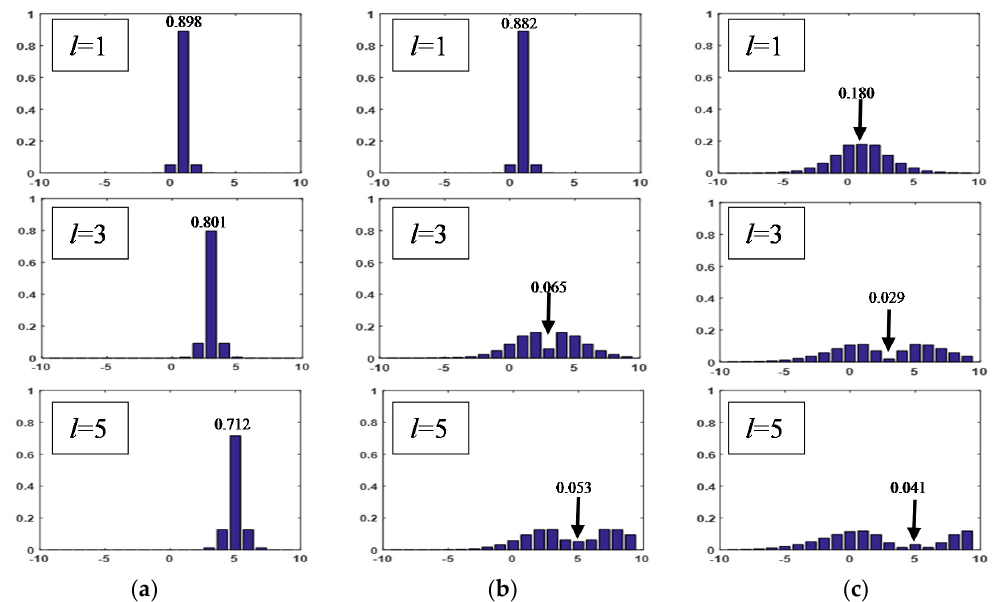
Figure 4. Variance of crosstalk with the transmission distance ( a ) 1 km, ( b ) 5 km and ( c ) 10 km under moderate-to-strong turbulence conditions. moderate-to-strong turbulence conditions. Appl. Sci. 2019 , 9 , x FOR PEER REVIEW